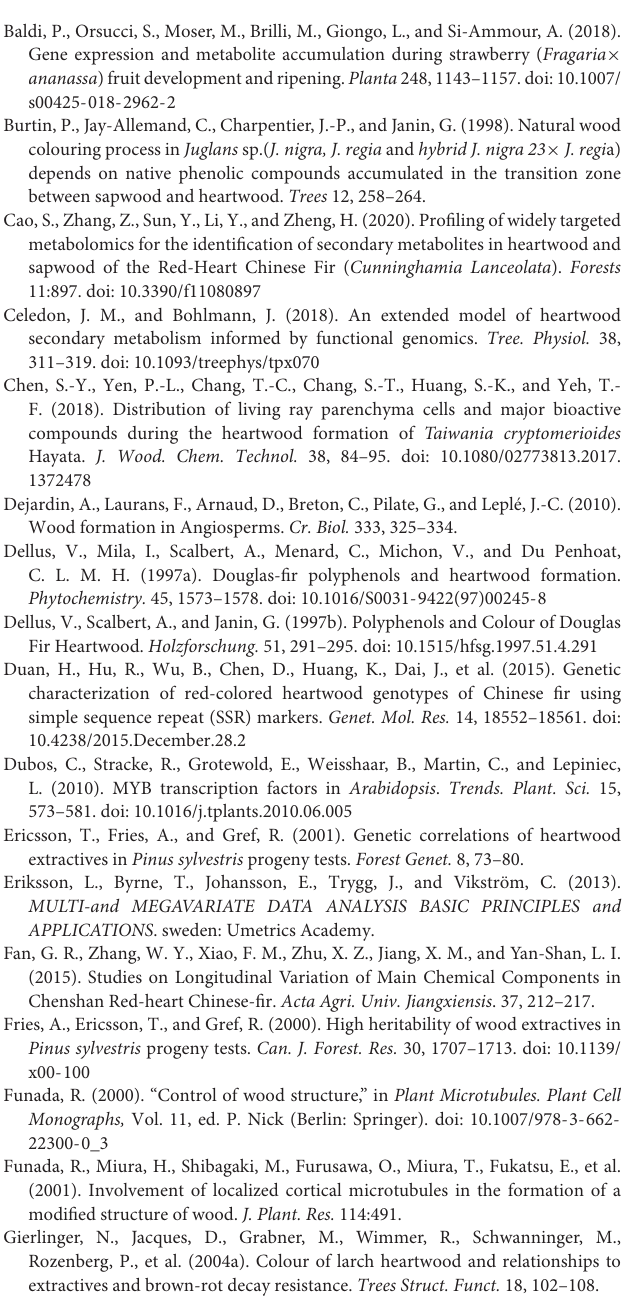
Supplementary Figure 5 | Phylogenetic relationship of Contig_6255 , Contig_73962 , Contig_3062, and other MYBs. The genes used for alignment